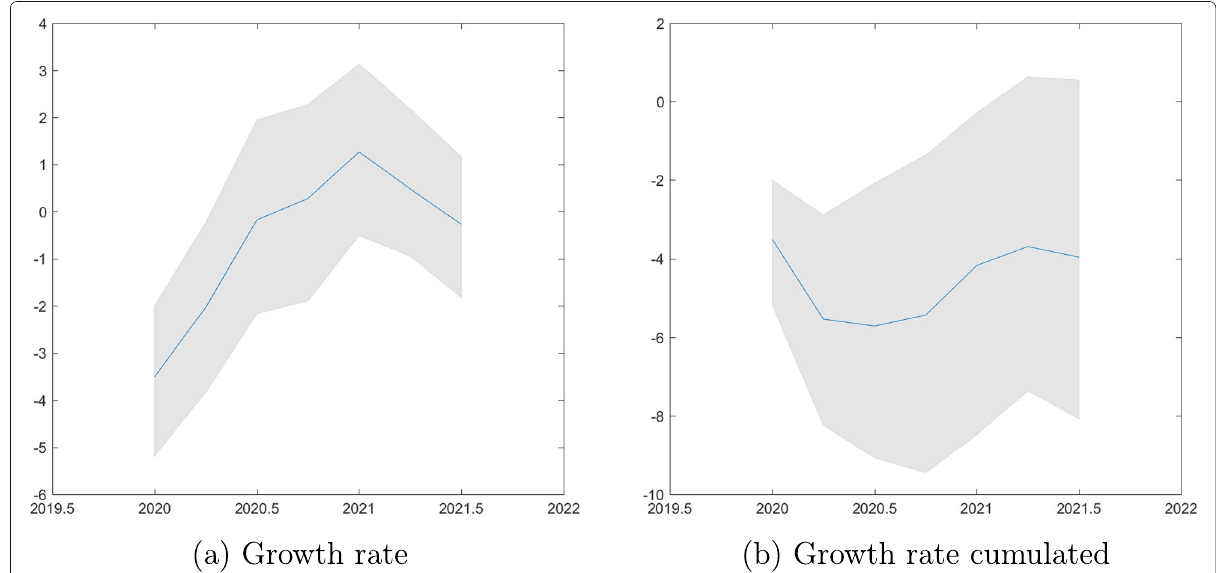
Fig. 9 GDP growth. Forecast period: First quarter 2020–third quarter 2021. Forecast conditional on shocks in log short-time workers up to April 2020